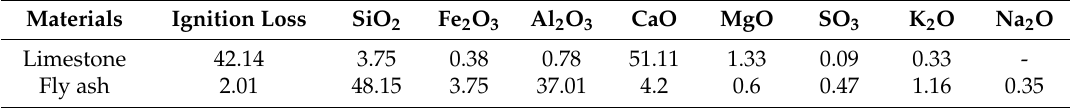
Table 1. Chemical compositions of industrial raw materials (wt.%).